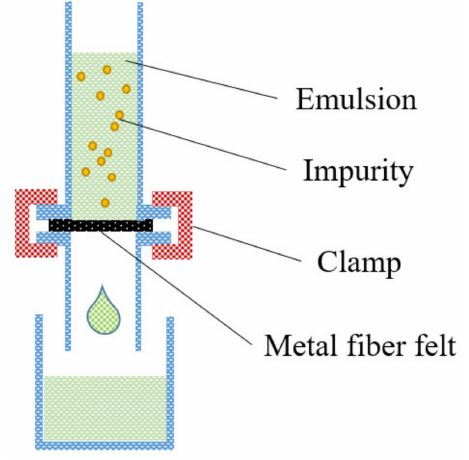
Figure 2. Schematic diagram of experimental